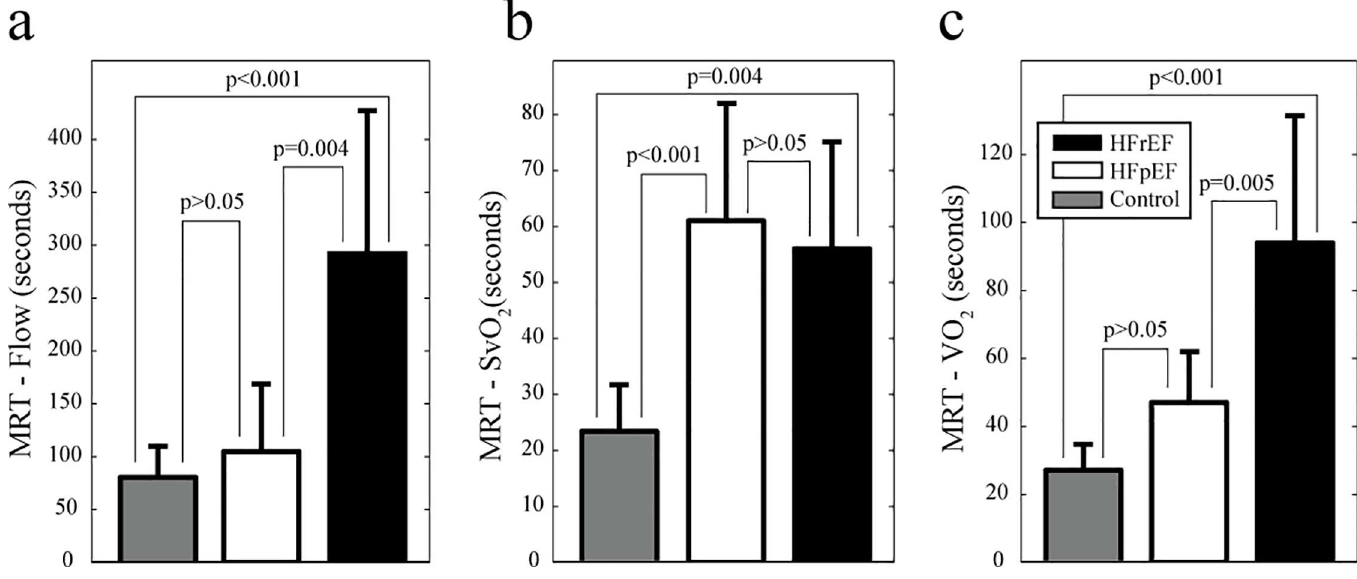
Fig 5. Mean response times. Mean response times (MRT) for ( a ) muscle blood flow, ( b ) SvO 2 and ( c ) VO 2 followingknee-extension exercise. Control data from a previous study using an identicalacquisition protocol [16].